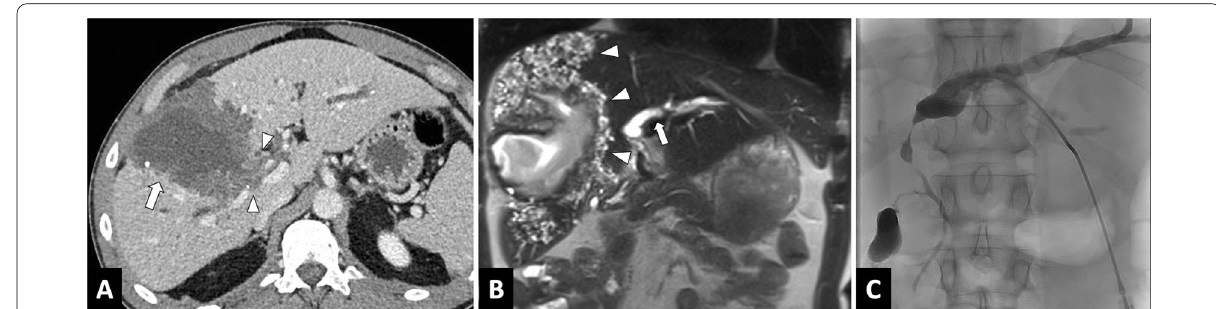
Fig. 6 Large alveolar echinococcosis lesion of the right liver in a 34‑year‑old man diagnosed with jaundice. A CT image in the axial plane obtained at portal phase of enhancement showing alveolar echinococcosis of the right liver (arrow) associated with infiltration up to the right pedicle (arrowheads) and the biliary convergence. B Coronal T2‑weighted MR images. Multiple microcysts (arrowheads) with biliary convergence involvement leading to biliary dilation in the left lobe (arrow). C Cholangiography images. Percutaneous biliary drainage to achieve regression of